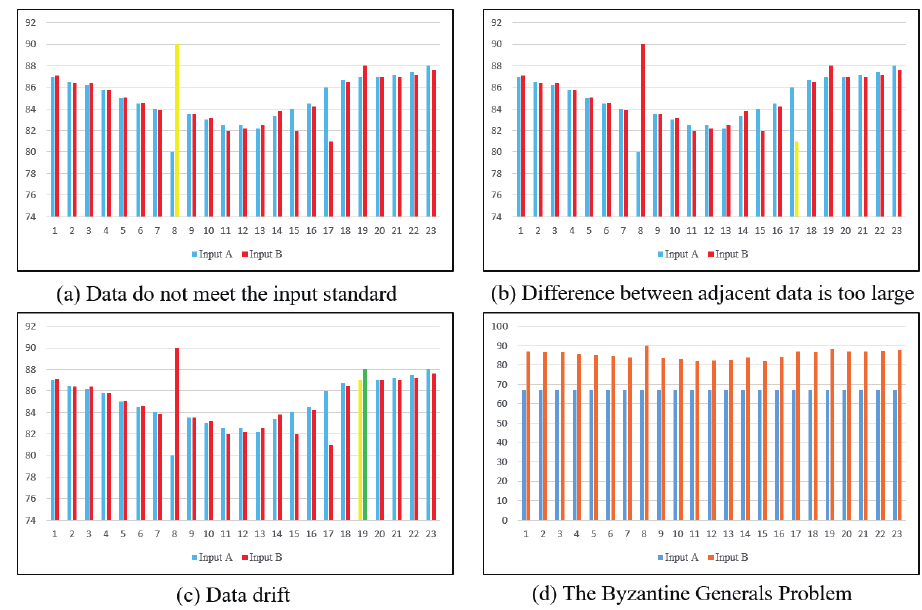
Figure 1. The architecture of the improved onboard safety computer